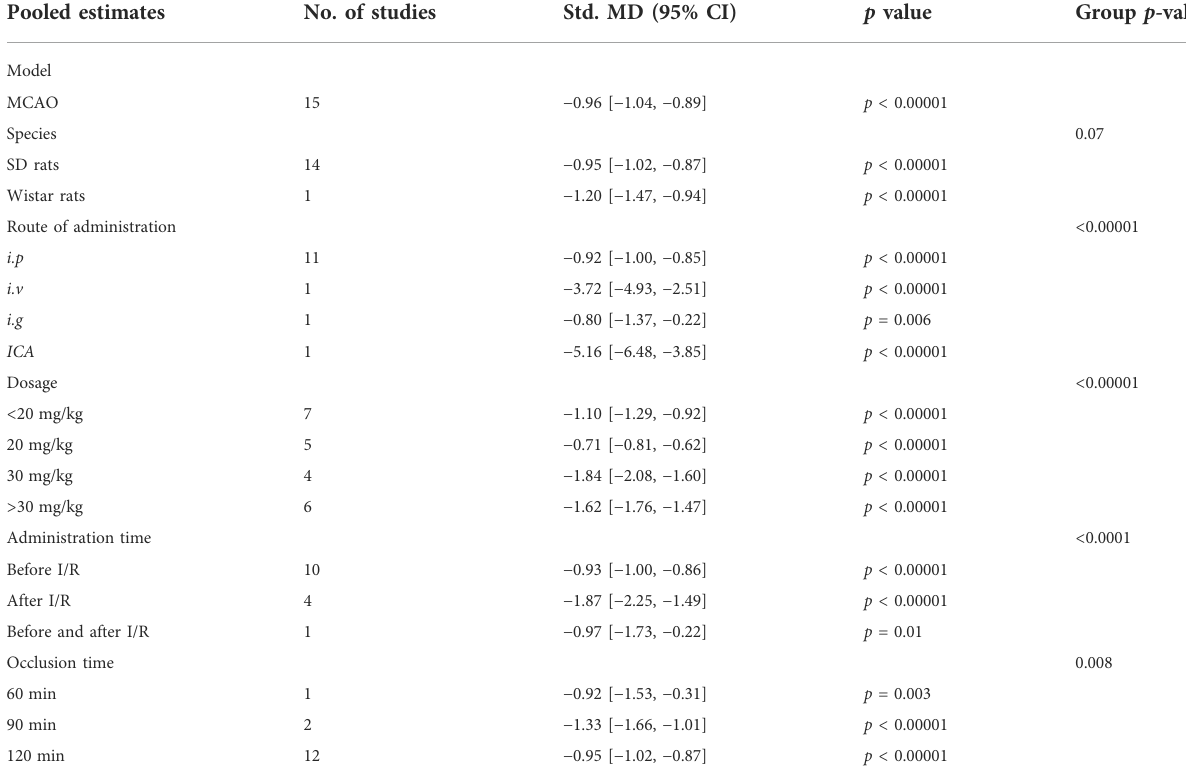
TABLE 5 Summary of subgroup analysis on neurological de fi cit scores.